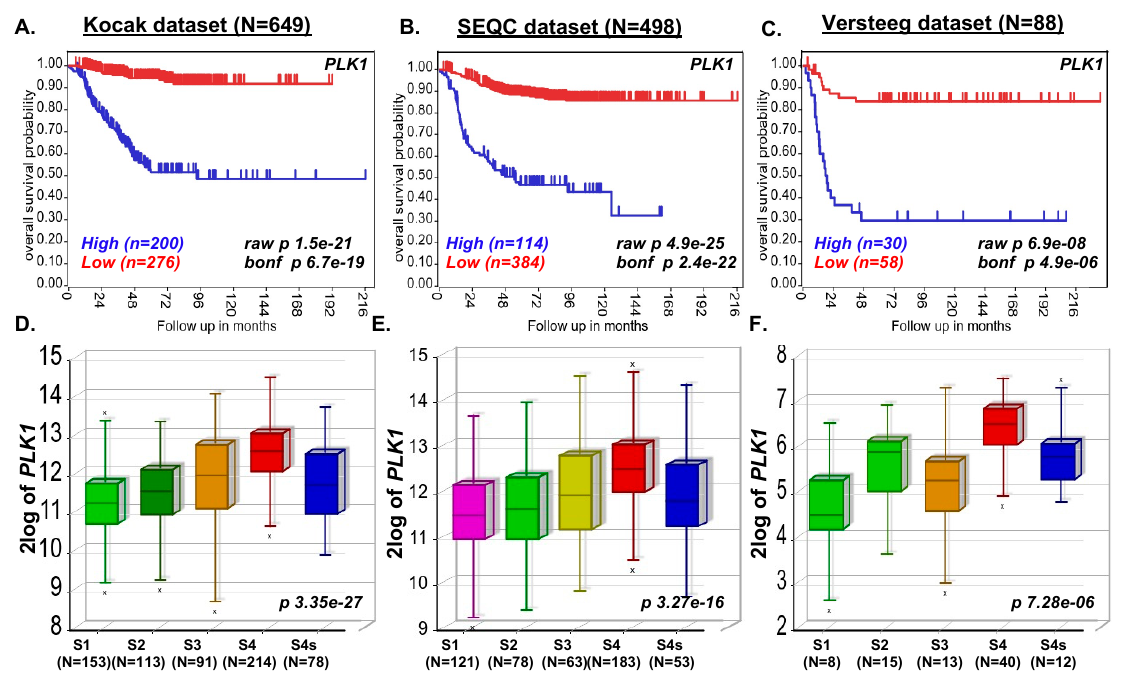
Figure 1. PLK1 expression correlates with poor overall survival of NB patients. Kaplan–Meier analysis of PLK1 gene showing poor overall probability of NB patients’ survival. ( A ) Kocak dataset (N = 649 patients). ( B ) SEQC dataset (N = 498 patients). ( C ) Versteeg dataset (N = 88 patients). ( D – F ) Correlation of PLK1 expression with NB stage progression. ( D ) Kocak dataset ( E ) SEQC dataset ( F ) Versteeg dataset. N represents the number of patient samples.